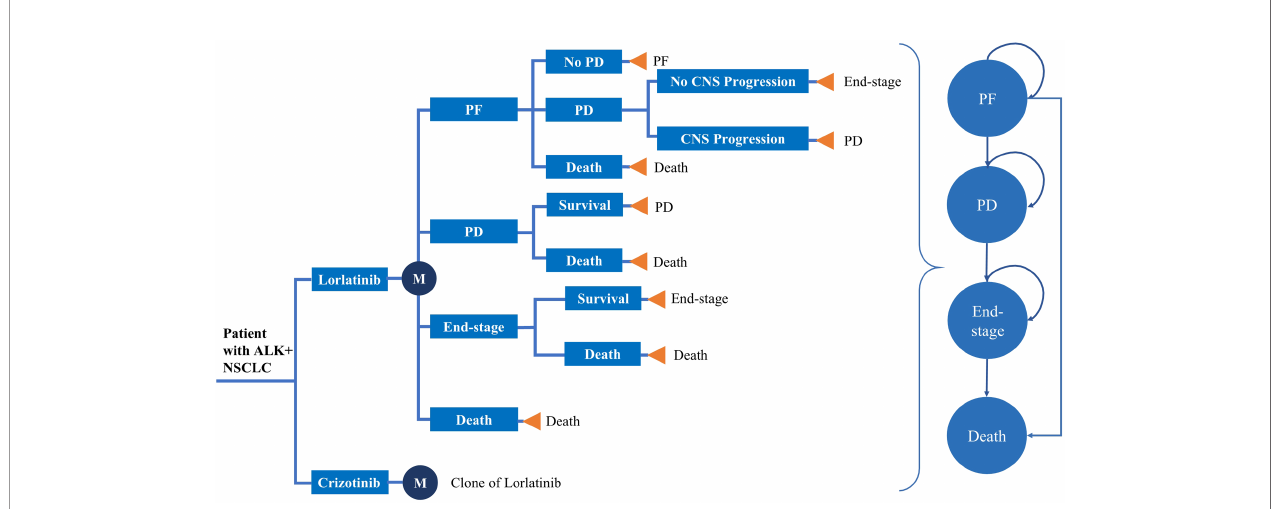
FIGURE 1 | Model structure. *ALK, anaplastic lymphoma kinase; NSCLC, Non-small cell lung cancer; PF, progression-free; PD, progressive